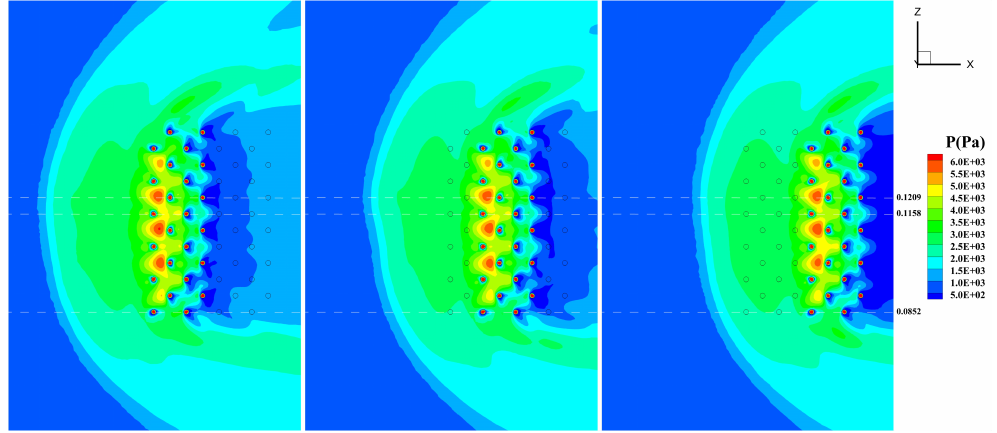
Figure 16. Detailed Lower Surface Pressure Distribution in Case 6 ( Left , C M = 0.002430), Case 7 ( Middle , C M = 0.002487) and Case 8 ( Right , C M =